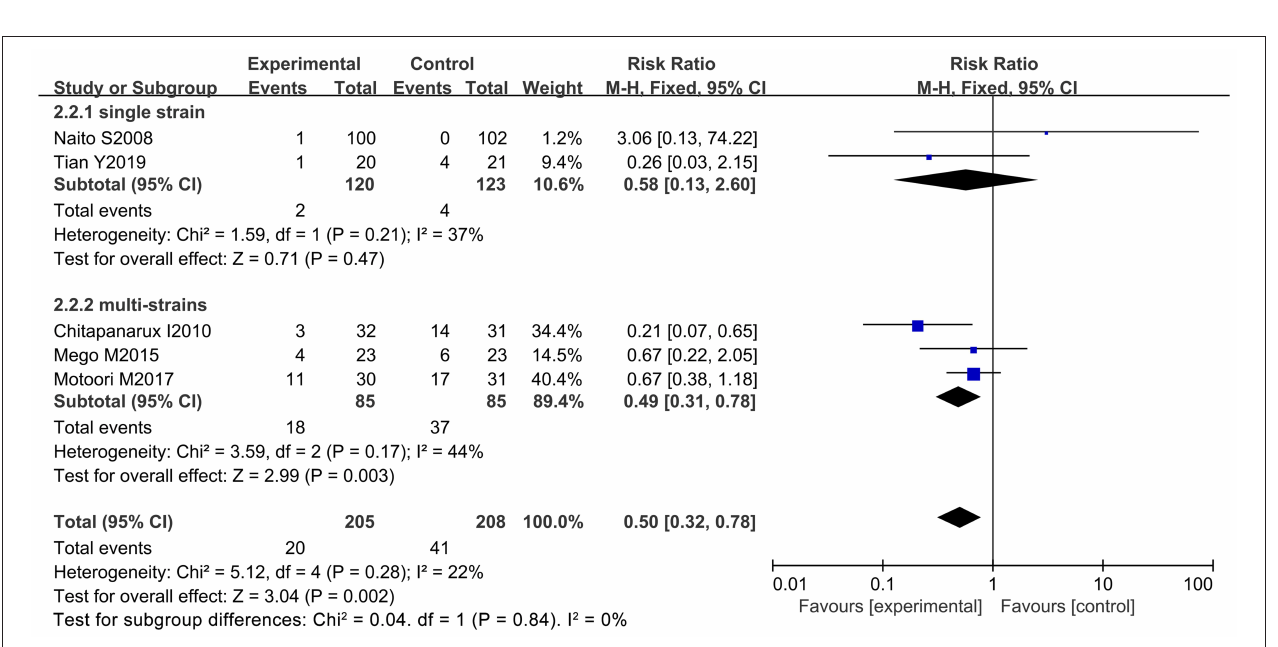
any significant effects on the incidence reduction of diarrhea